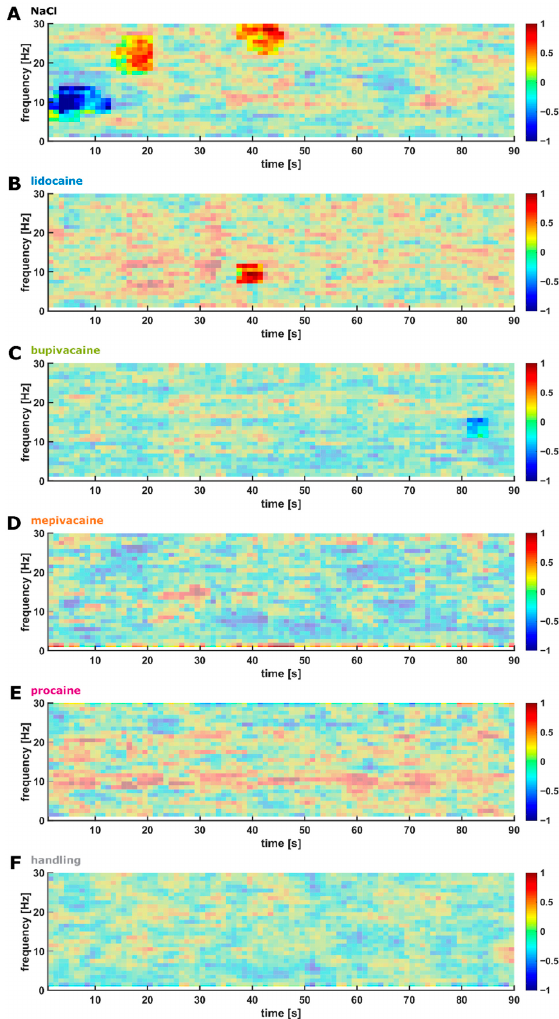
Figure 4. DSAs of the EEG Changes after Spermatic Cord Dissection. The DSAs present changes in EEG power over 90 s following spermatic cord dissection in the following experimental groups: NaCl ( A ), lidocaine ( B ), bupivacaine ( C ), mepivacaine ( D ), procaine ( E ), and no incision or handling only ( F ). Stimulus started at t = 0. ( A ) In the NaCl group, an ‘early‘ and ‘late‘ response to the dissection stimulus was observed. The early response was an attenuation in the ~5–15 Hz range within the first 15 s after stimulation, and the late response was an activation of ~20–30 Hz at approximately 20 and 30–40 s after stimulation. ( B – F ) No significant changes in the EEG power were observed in the local anaesthetic and handling groups following the stimulus, except for an activation of ~10 Hz power at approximately 40 s after stimulation in the lidocaine group ( B ) and a late decrease in ~15 Hz power at approximately 80 s in the bupivacaine group ( C